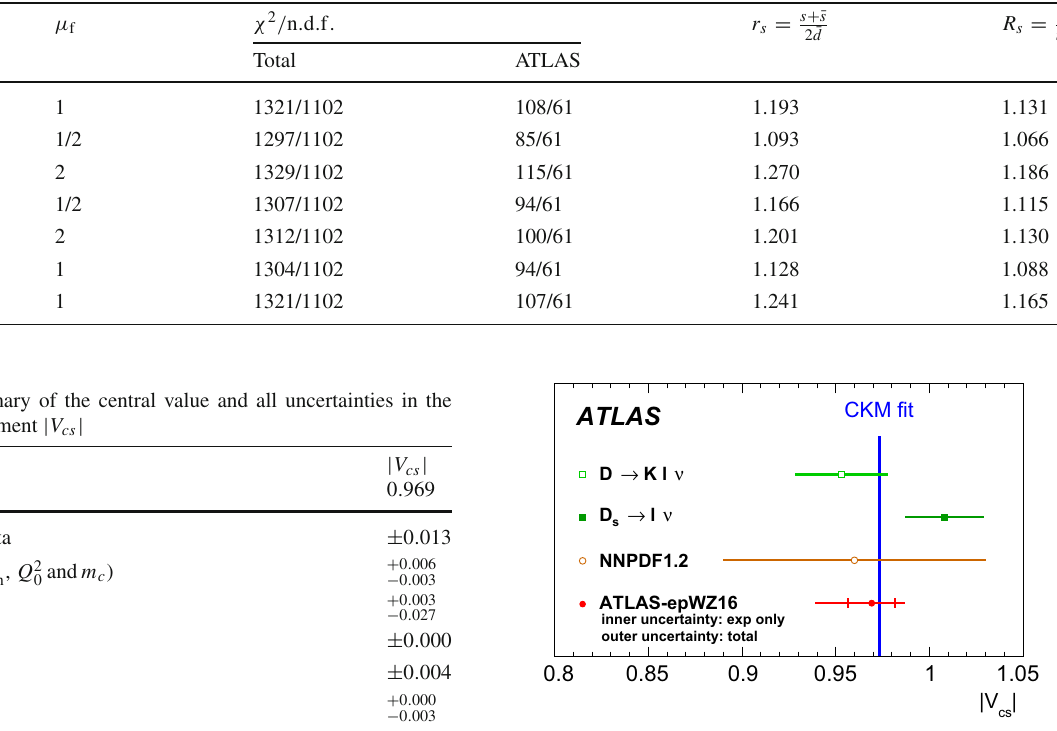
exclusively due to variations of the ATLAS values while the HERA χ 2 , given by their difference, remains nearly constant. Right columns: resulting r s and R s values, quoted at Q 2 = Q 2 and x = 0 . 023 0